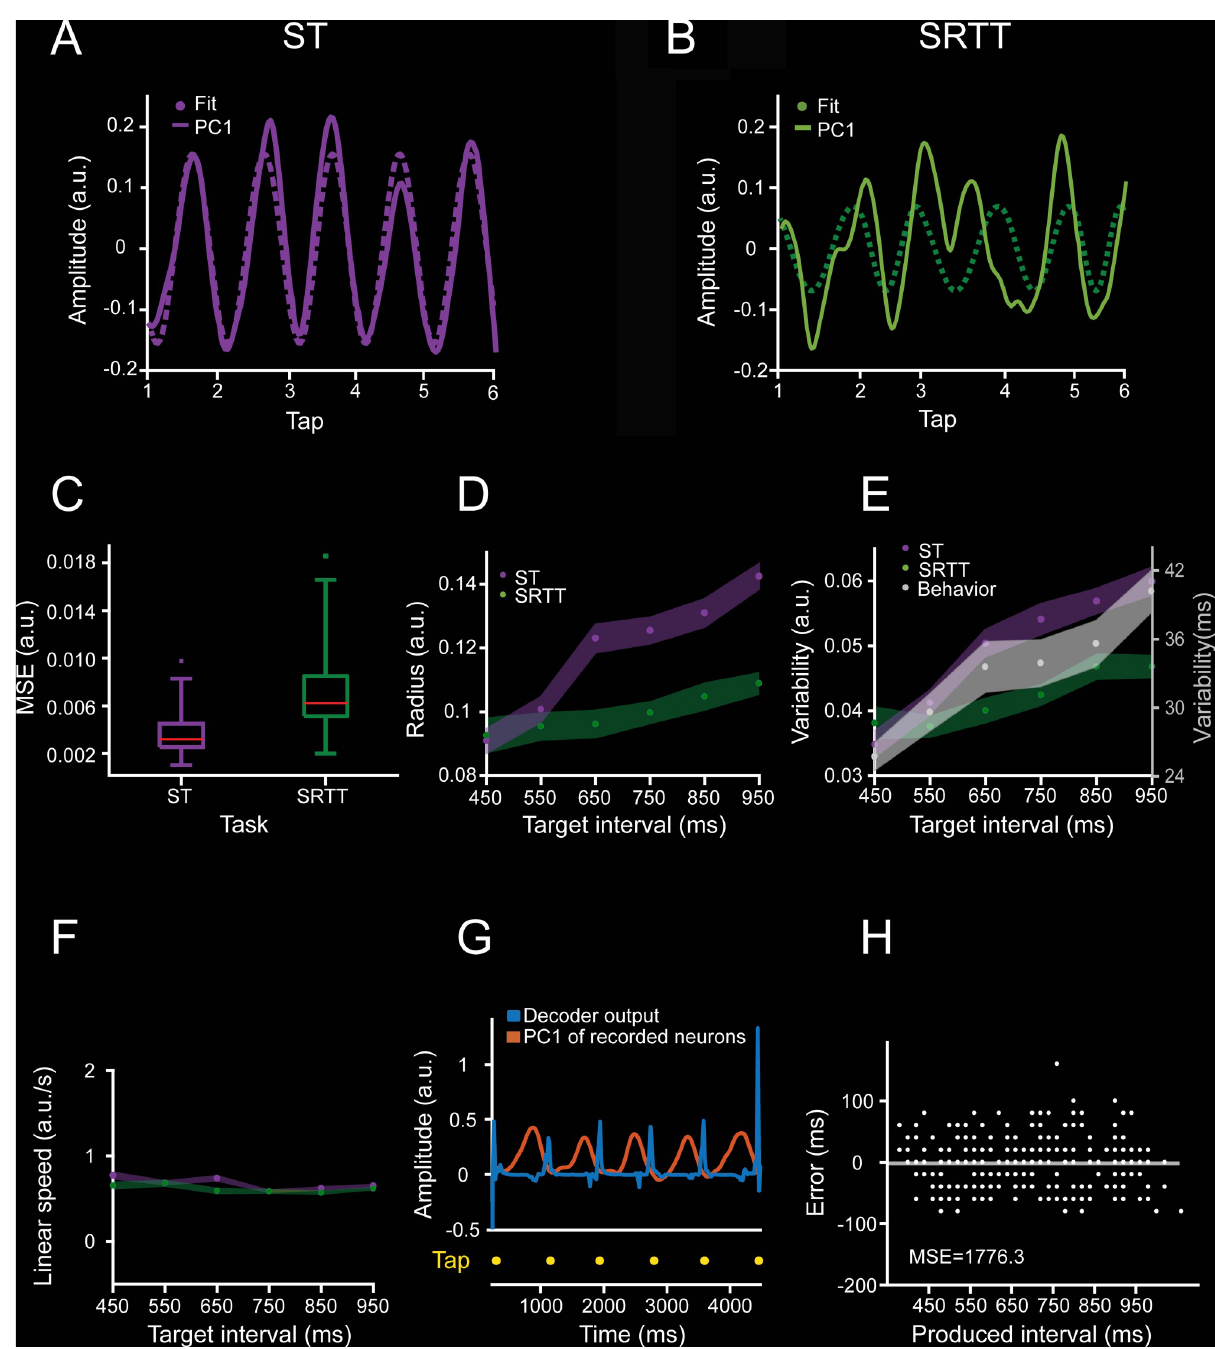
Fig 4. Comparison of ST and SRTT trajectories in simultaneously recorded neurons. A . Neural activity data projected on the PC1 (solid line, linearly detrended) and the correspondent sinusoidal fit (dotted line) during a trial of ST for the target interval of 650 ms. B . Similar to (A) for SRTT. Note that the strong periodic structure of the ST neural trajectory is lost during SRTT for the same population of cells. C . The MSE of the sinusoidal fits during ST (purple) is significantly smaller than during SRTT (green; 60 trials, two-sample t test = − 6.78, p < 0.0001). D . Radii of the neural trajectories during ST (purple, slope = 0.000087, constant = 0.055, R 2 = 0.619, p < 0.0001) and SRTT (green, nonsignificant linear regression, R 2 = 0.0172 and p = 0.489) as a function of target interval. E. Variability of the neural trajectories during ST (purple, data slope = 0.000037, constant = 0.028, R 2 = 0.368, p < 0.0001), SRTT (green, nonsignificant linear regression, R 2 = 0.0005 and p = 0.903), and temporal variability of the monkeys’ produced intervals (gray, mean ± SD/2, data slope = 0.0009, constant = − 0.003, R 2 = 0.999, p < 0.0001) across target intervals during ST. F. Linear speed of neural trajectories during ST (purple, mean ± SD, slope = 0.0001, constant = 7.322, R 2 = 0.0007, p = 0.896) and SRTT (green, mean ± SD, slope = 0.002, constant = 4.049, R 2 = 0.354, p = 0.002) did not change as a function of target interval. G. Output of the time-delay neural network (TDNN, in blue)